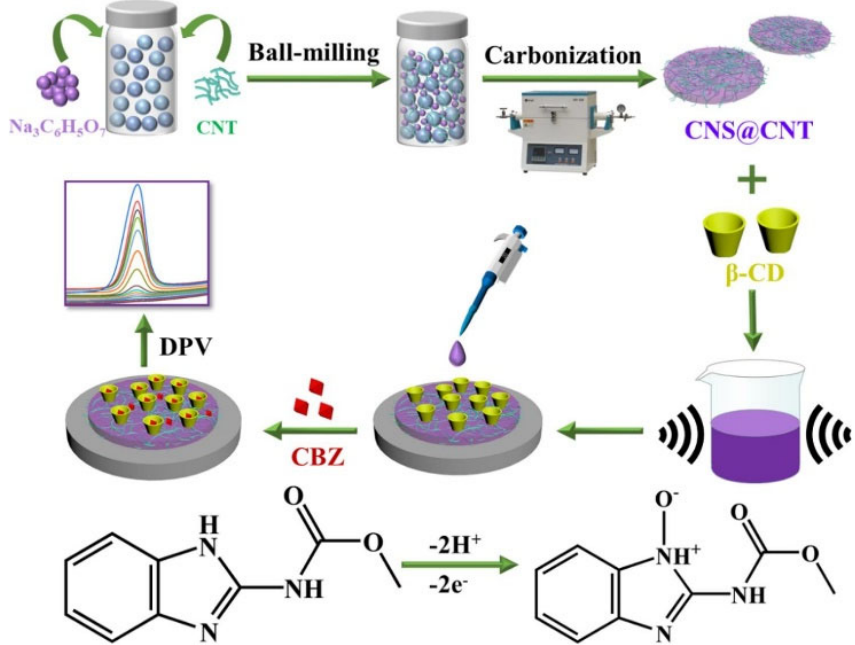
Figure 13. Fabrication schematic of β -CD/CNS@CNT/GCE sensor (Reprinted with permission from Ref. [48]. 2022, Liu et al.).